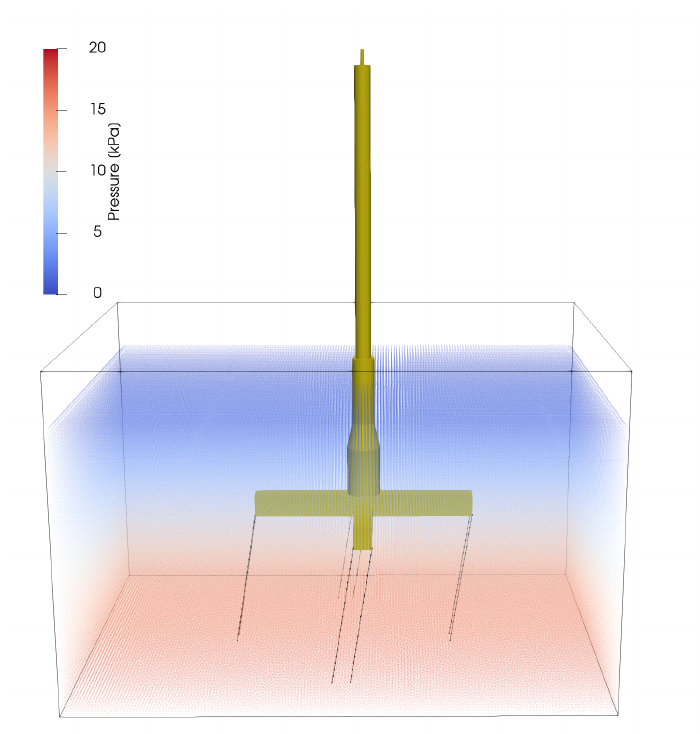
Figure 4. Perspective visualization of the numerical model during the decay test: the fluid is indicated by the colored particles (coloring indicates pressure), whereas the geometry of the TLP is reported as a solid